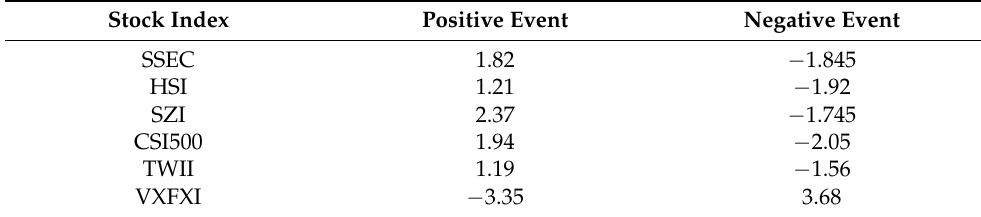
Table 6. Changing stock market indices median values caused by two types of